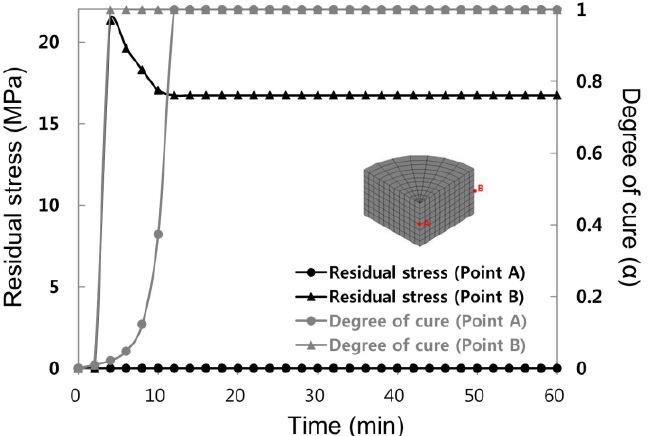
Figure 5. Residual Stress evolution and degree of cure during one-step curing at Points A and